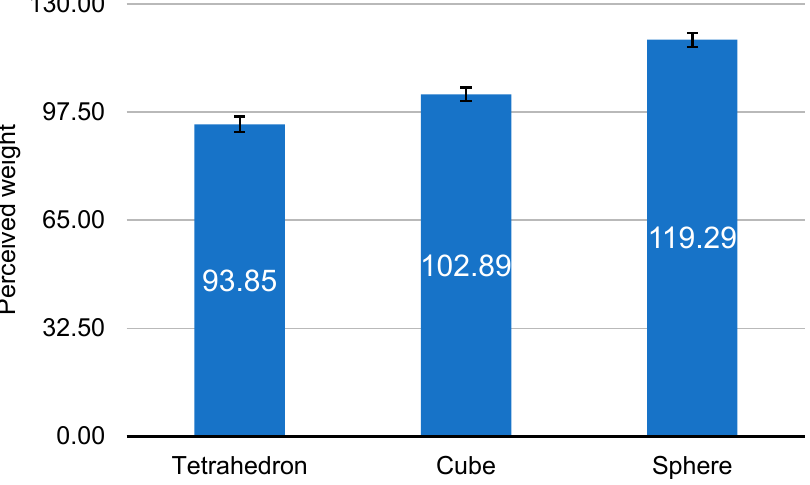
Figure 3. Perceived weight with 3 shapes.